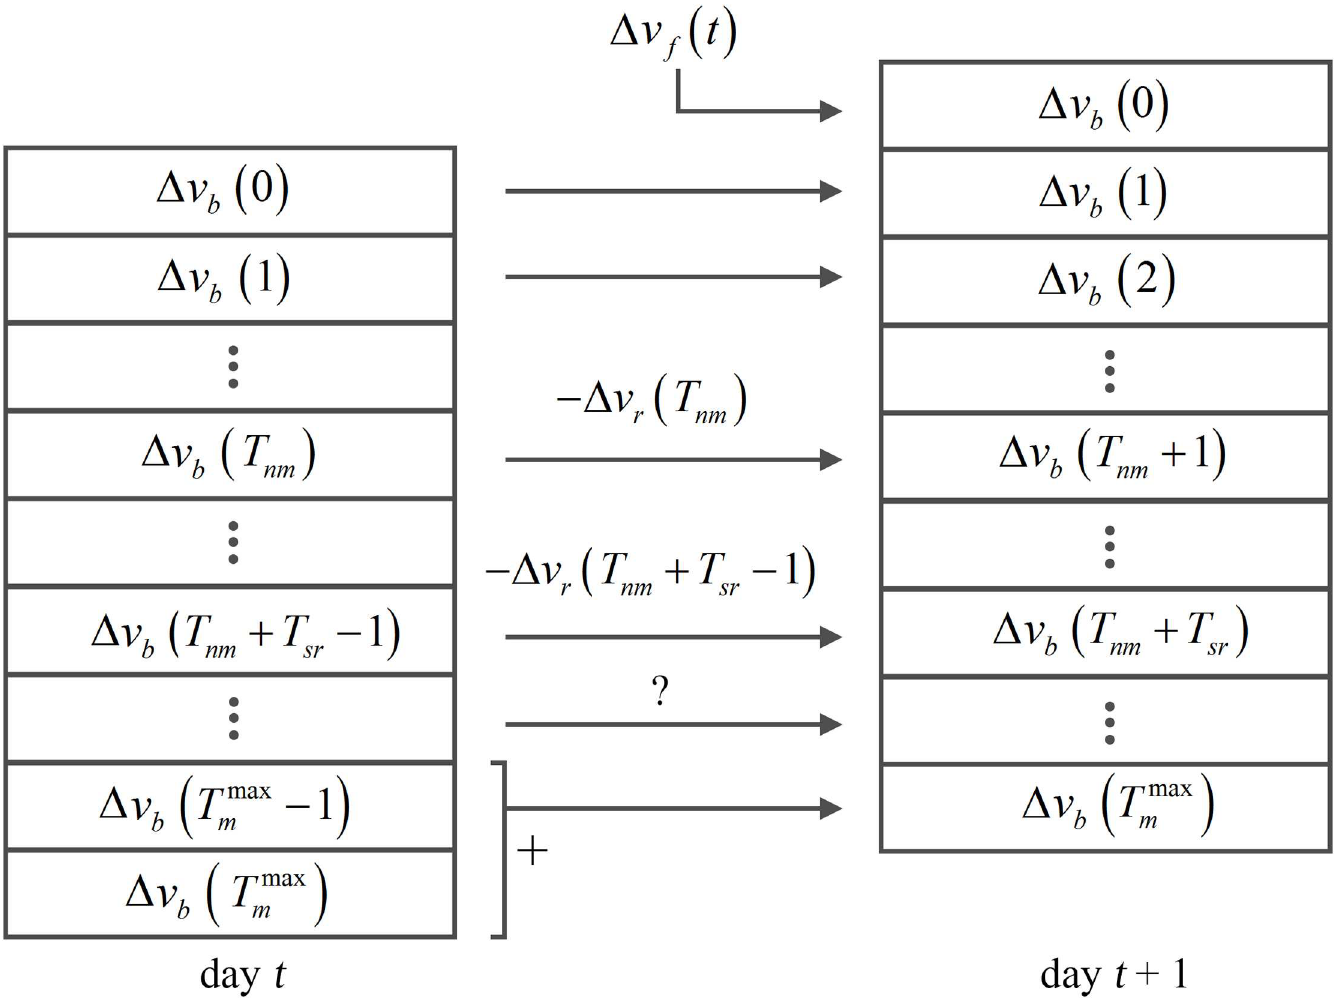
þ 1). The resorptionstarts on those components between T nm and m ) is stored at m